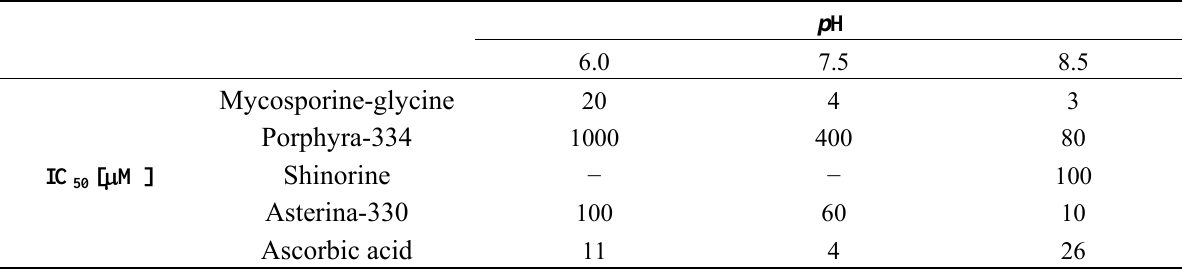
values of several MAAs against 2,2'-azinobis(3-ethylbenzothiazoline-6- Table 2. The IC 50 sulfonic acid) (ABTS) radicals at different pH